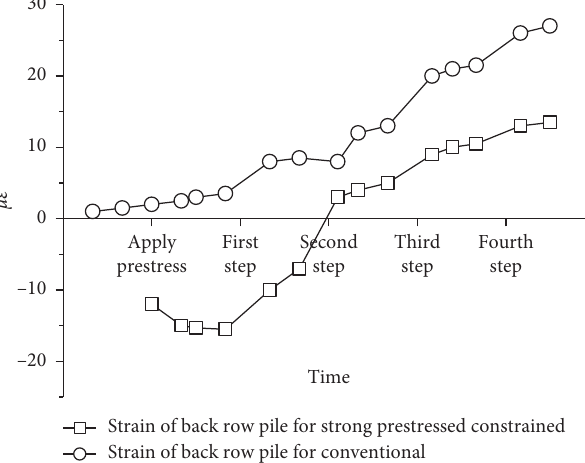
Figure 20: Comparison of strain at 2m below the back row pile